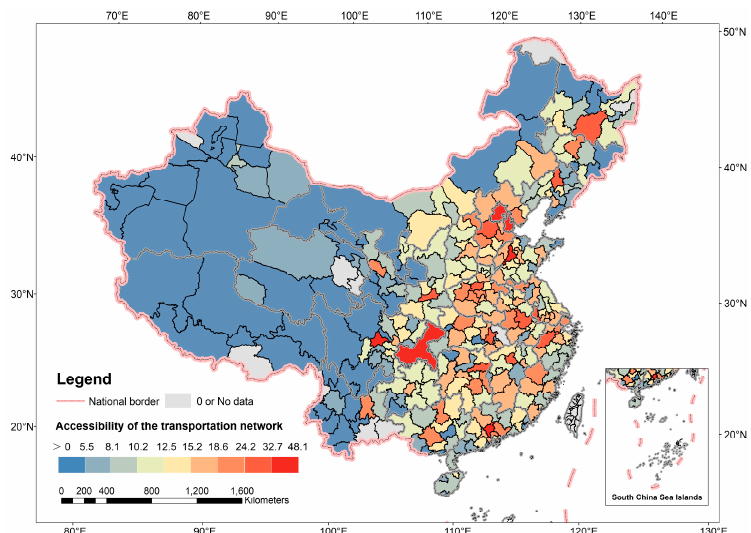
Figure 6. Transportation accessibility in Chinese cities.